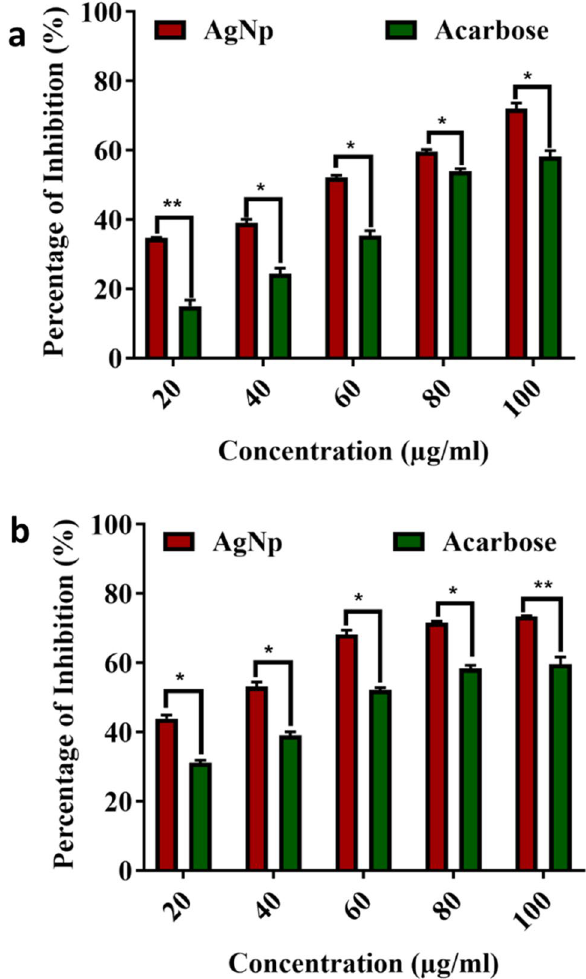
Figure 5. Inhibition of carbohydrate hydrolyzing enzymes by the AgNPs synthesized from A. sativum extract. ( a ) Inhibition of α-Amylase ( b ) Inhibition of α-Glucosidase. (Data was represented as mean ± SD * P < 0.05); ** P <